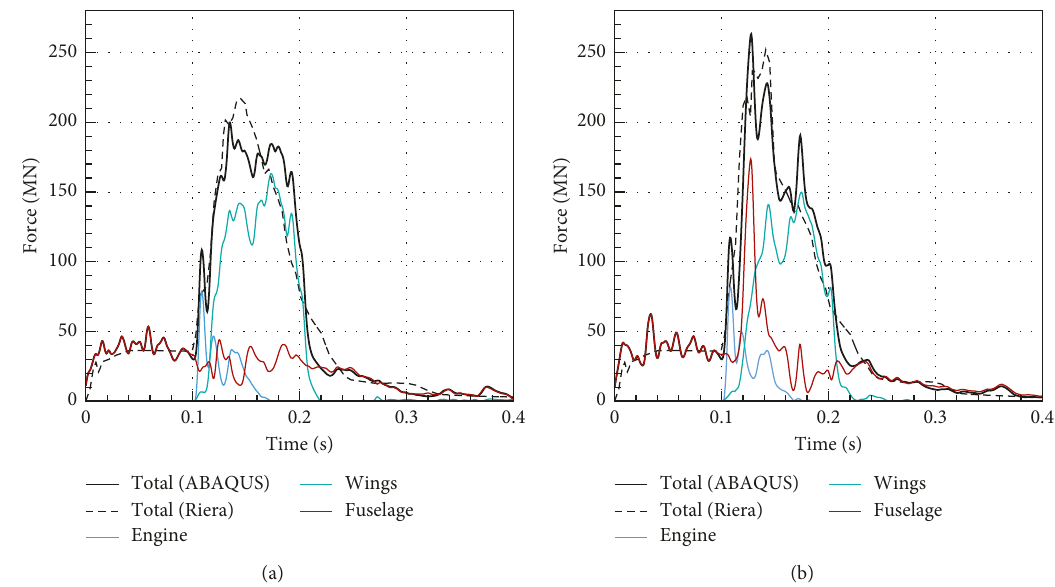
Figure 4: Force-time history results of Boeing 767-200ER. (a) WT case. (b) CT case.